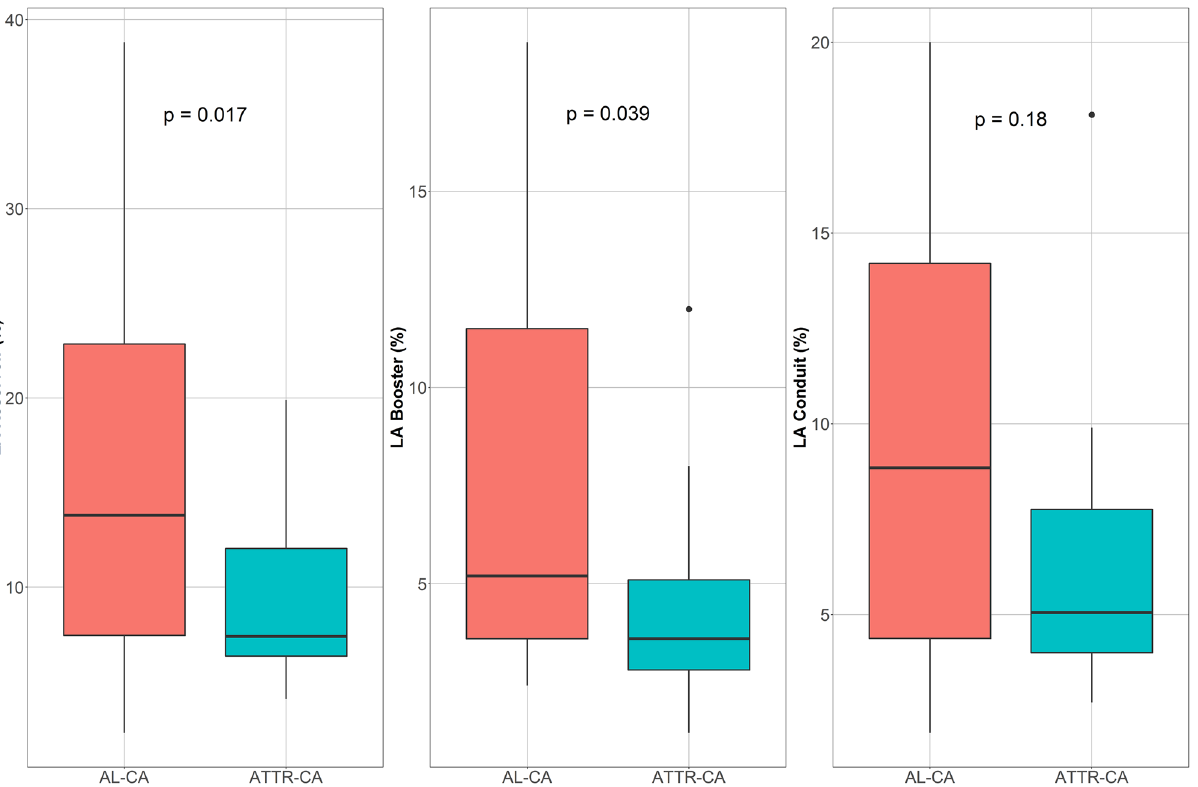
Figure 1. Box-and-whisker plot showing ATTR had significantly lower LA strain compared to